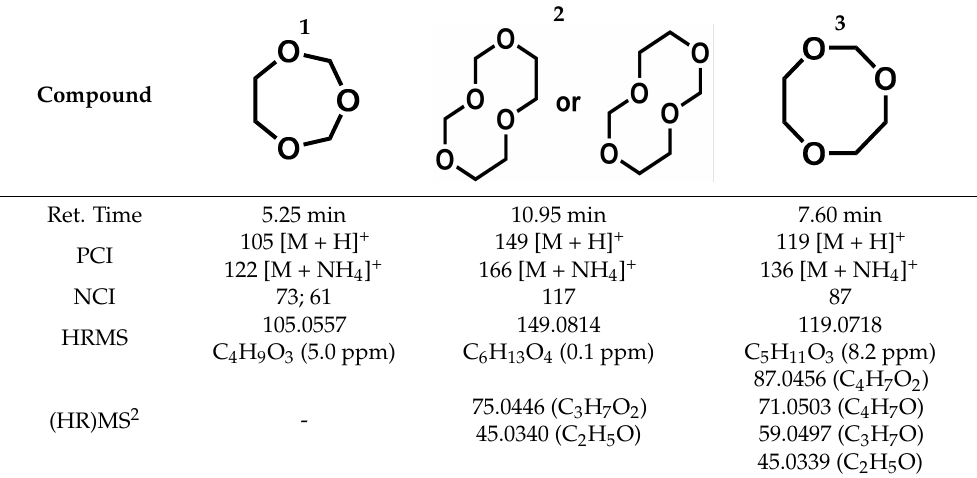
Table 1. Summary of the MS data from compounds of interest in DOL/DME-based systems. Parental fragments of compound 1 were too small to provide significant daughter ions in fragmentation experiments.